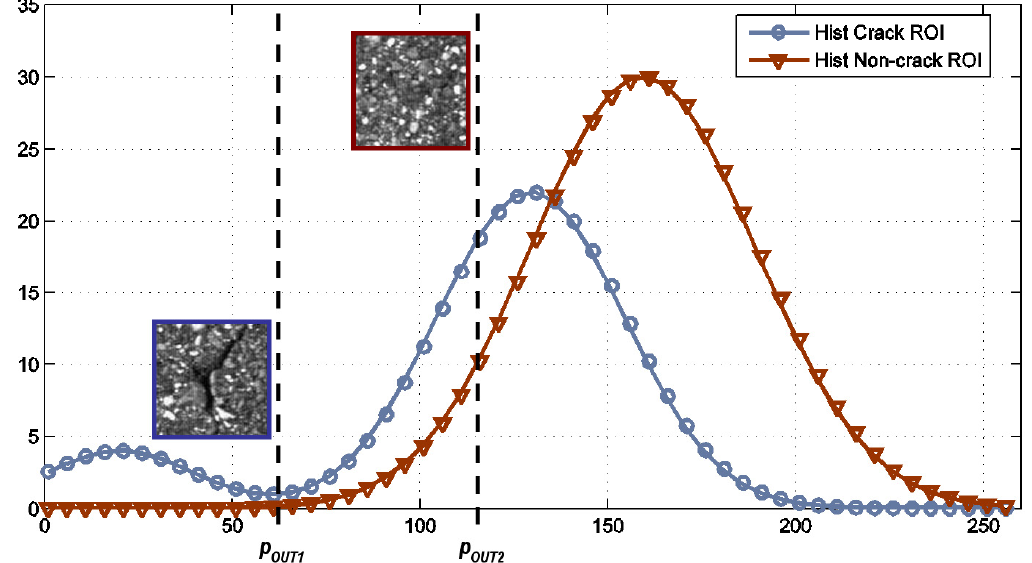
Figure 3. Histograms corresponding to crack area (blue) and non-crack area (red).